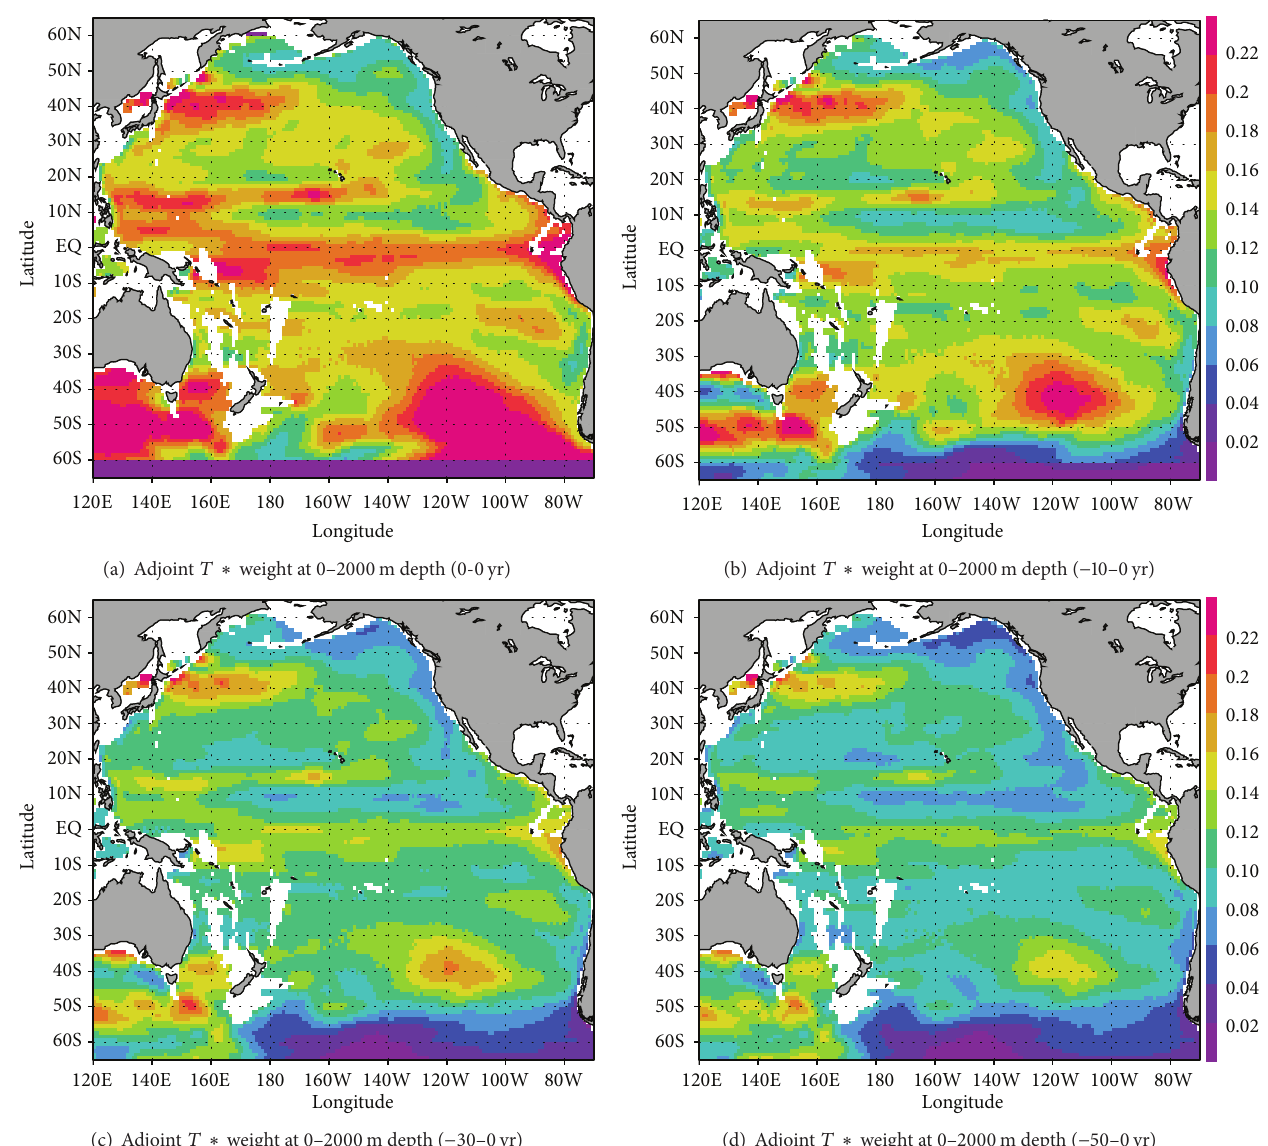
Figure 4: Modified sensitivity calculated as the product of the sensitivity values shown in Figure 2 and the square root of temperature error. The values are averaged over the upper 2000 m of the water column and within specified windows of time. The windows of time are (a) 0 years, (b) 10 years, (c) 30 years, and (d) 50 years (see Section 3.2 in the text for details). The units are in